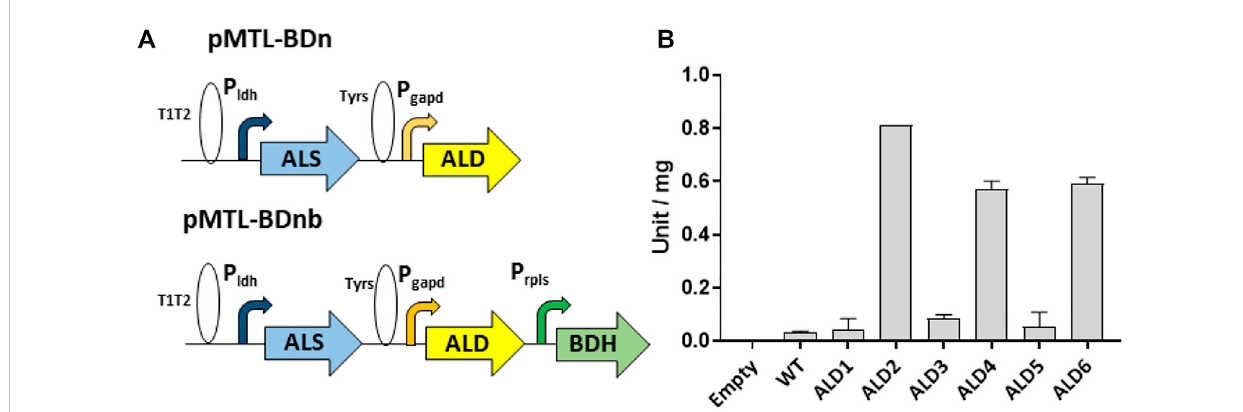
FIGURE 1 Assembly of enzyme variants in the acetoin/2,3-BDO pathway and assay of acetolactate decarboxylase activities. (A) Gene con fi guration of the constructedacetoin/2,3-BDOpathway.TheALSgeneisexpressedfromthe G.stereothermophilus lactatedehydrogenasepromoter(P ldh )withthenative RBS, the ALD gene is expressed via PT glyceraldehyde 3-phosphate dehydrogenase promoter and RBS9 (TAGATAAAGGAGGTAGAACT, taken from the RBSofthelocustagCLB_1812of Clostridiumbotulinum ATCC3502,accessionno.CP000726)whiletheBDHgeneisexpressedfromthenative rplS promoterand G.stereothermophiluspheB RBS. T1T2and TyrS aretranscriptional terminatorsfromthe E. colirrnB and B.subtil is tyrS genes,respectively. (B) Assayof α -acetolactatedecarboxylases expressed inPT.Y-axis representsunitpermgofproteininthecrude celllysate. Errorbarsrepresentstandard deviation, n =